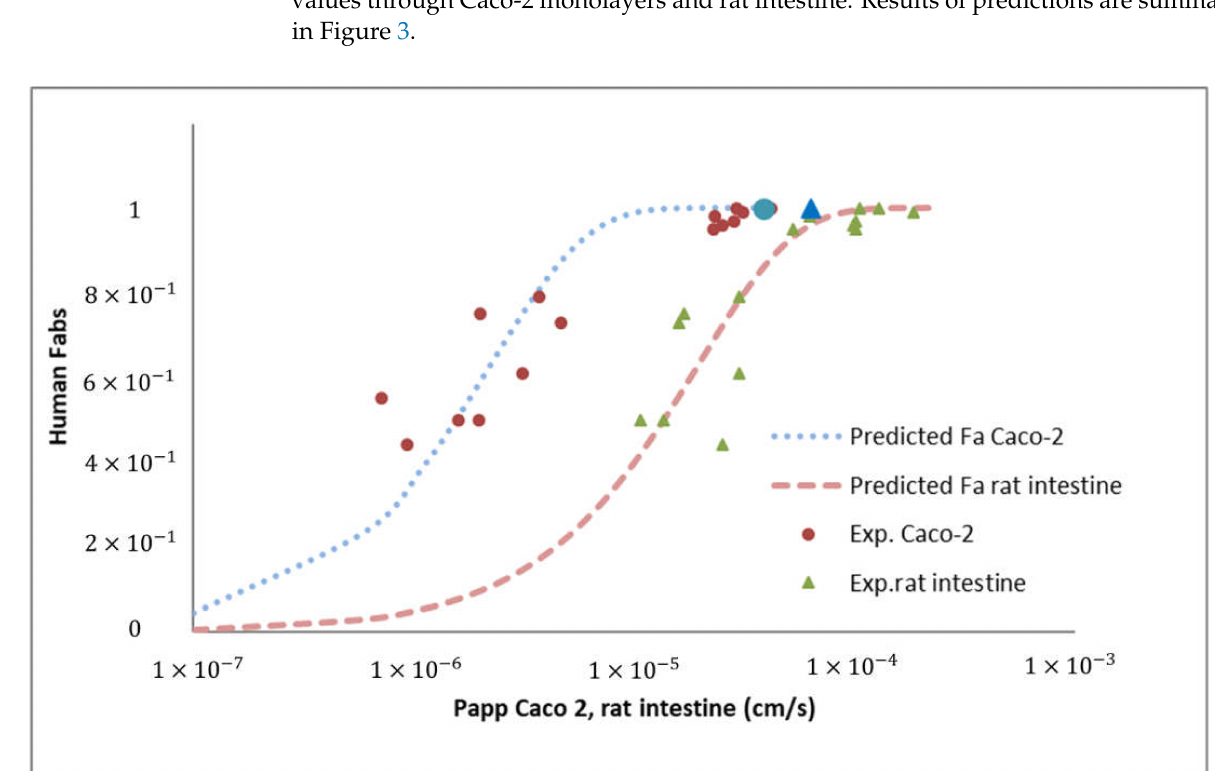
Figure 3. Human fraction absorbed vs. Permeability values in Caco-2 monolayers (apical to basal) or rat intestine. Blue circle and triangle correspond to JM-20 Caco-2 and rat intestine permeability values. Dotted lines correspond to our validated correlation between both techniques and human fraction absorbed